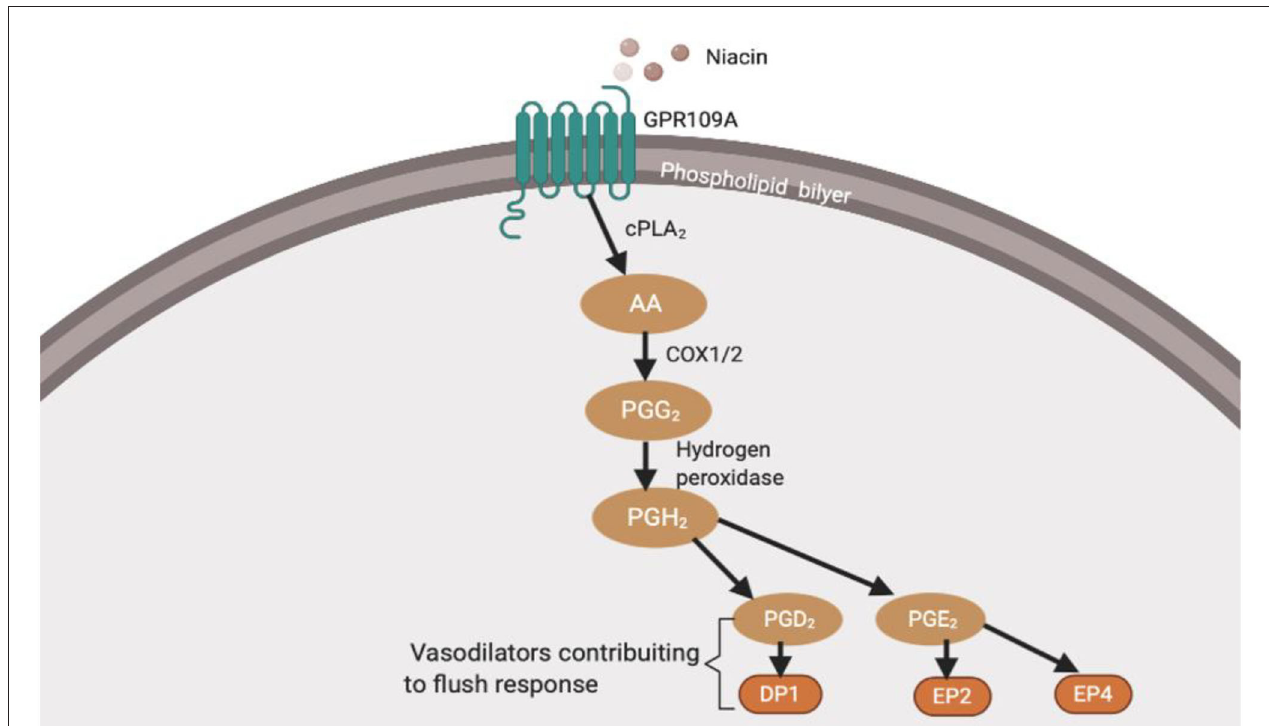
FIGURE 1 | Niacin binds and activates GPR109A receptors on dermal cells, epidermal langerhans cells, and adipose macrophages (27). In langerhans cells, the activated receptor releases intracellular calcium (Ca 2 + ) ( 28), which triggers phospholipase A 2 (PLA 2 ) to catalyse the breakdown of membrane phospholipid to arachidonic acid (AA). Available AA is converted to eicosanoid, prostaglandin G 2 (PGG 2 ) and prostaglandin H 2 (PGH 2 ) via COX1/2 and hydrogen peroxidase respectively. PGH 2 is converted to various prostaglandins, prostacyclins, and leukotrienes. However, because this thesis focuses on the diminished flush observed in schizophrenia, I will focus on prostaglandins (29). Mediators involved in the cutaneous flushing are vasodilators, prostaglandin D2 (PGD 2 ), and E2 (PDE 2 ), which activates prostaglandin D 2 receptor 1 (DP 1 ) and prostaglandin E 2 / 4 receptor (EP 2 / 4 ), respectively (25). Moreover, these are biochemical alteration which may be partially inherited (30, 31). However, the pathophysiology of the attenuated flush response is not fully